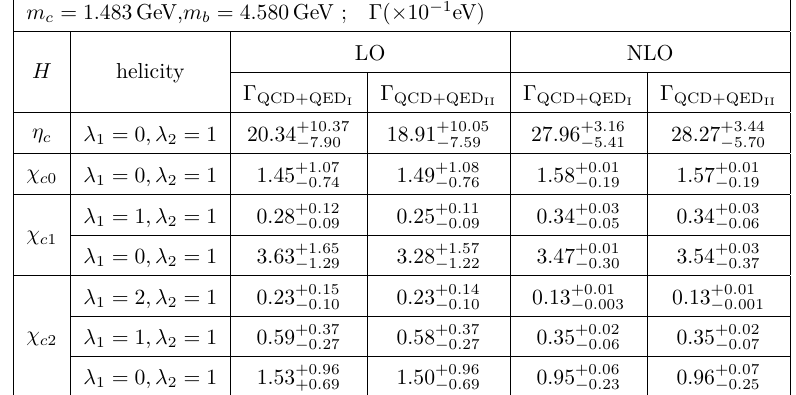
, the QED related I , the QED related contributions II